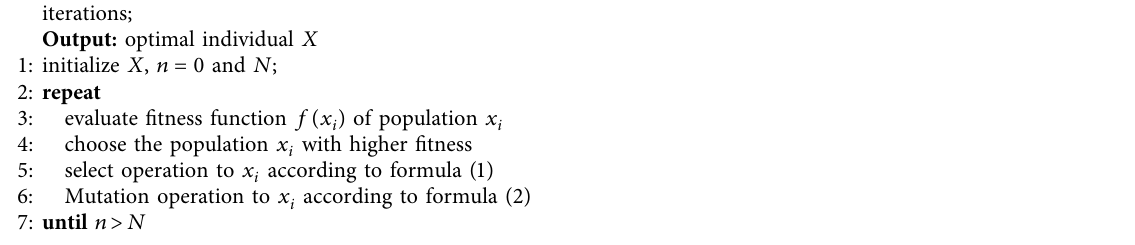
A LGORITHM 1: Traditional genetic